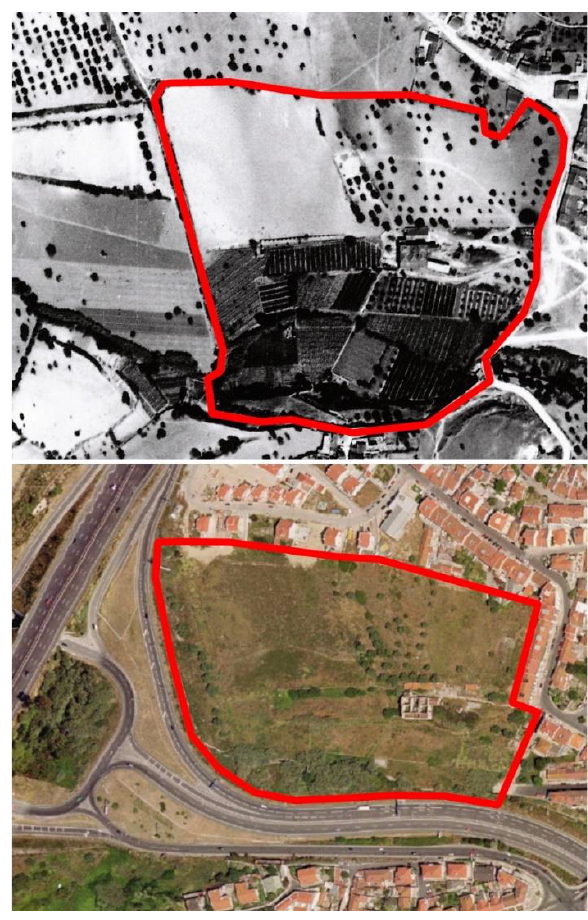
Figure 1. Aerial images oriented North/South. Top: 1944 (Source: Instituto Geográfico e Cadastral), Bottom: 2007 (Source: Municipality of Loures).